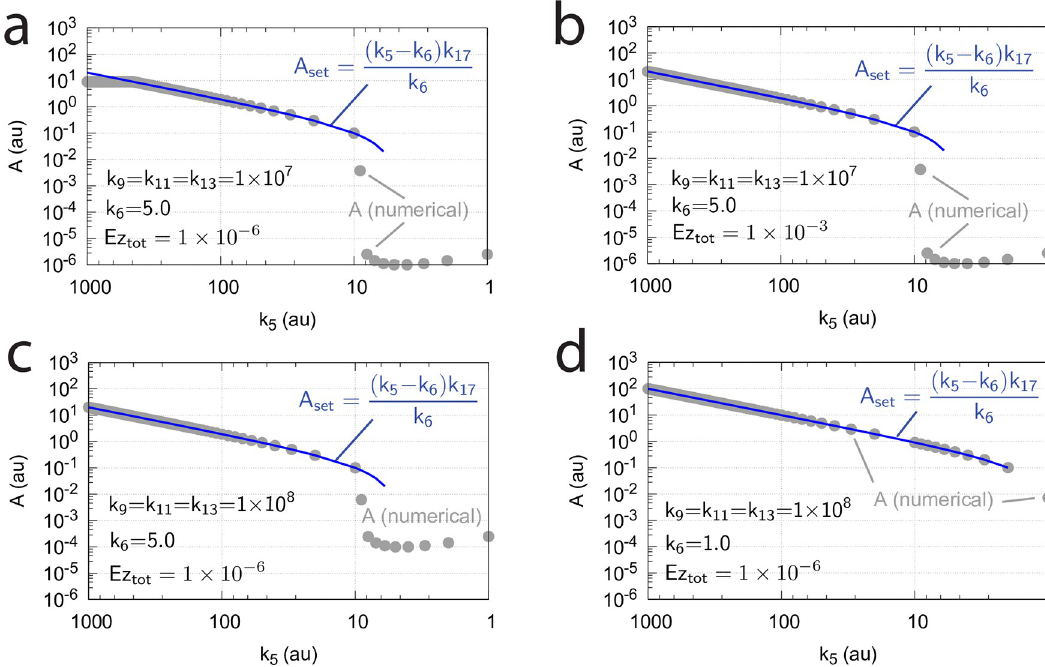
Fig 60. Influence of k 6 , k 9 , k 11 , k 13 and Ez on the homeostatic behavior of the m7 ping-pong controller when E 1 binds first to tot free enzyme Ez . Numerical A values calculated after 10 4 time units are compared with corresponding analytical expressions of A a function of k 5 . (a) k 6 =5.0, k 9 = k 11 = k 13 =1 × 10 7 , and Ez tot =1 × 10 − 6 . (b) k 6 =5.0, k 9 = k 11 = k 13 =1 × 10 7 , and Ez tot =1 × 10 − 3 . (c) k 6 =5.0, k 9 = k 11 = k 13 =1 × 10 8 , and Ez tot =1 × 10 − 6 . (d) k 6 =1.0, k 9 = k 11 = k 13 =1 × 10 8 , and Ez tot =1 × 10 − 6 . Other rate constants (a)-(d): k 1 =100.0,